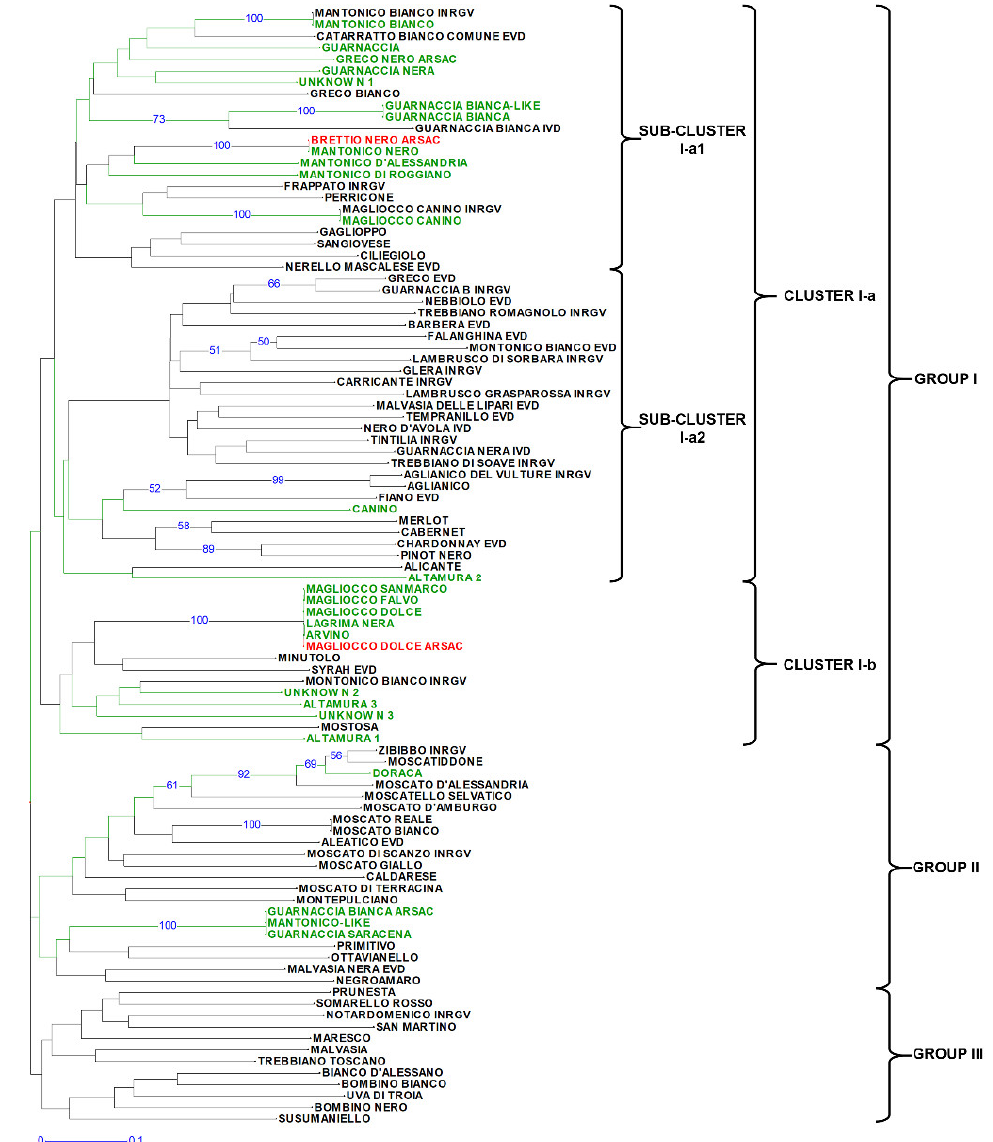
Figure 1. Unweighted neighbor-joining dendrogram obtained with SSR data from 64 grape accessions and 33 molecular profiles taken from three different grapevine databases (Italian National Registry of Grape Varieties, Italian Vitis Database and European Vitis Database). Samples collected in the Calabria region are green. Brettio Nero and Magliocco Dolce provided by ARSAC are in red.